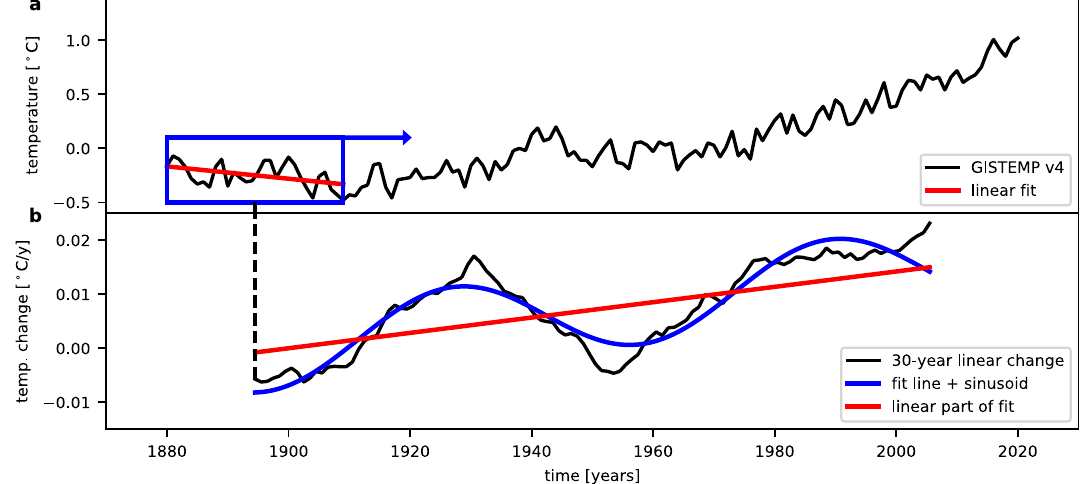
Figure 5. Long-term evolution of global annual mean surface temperatures. ( a ) The global annual mean surface temperature anomalies are shown as black curve. The blue box shows the first 30 year window used for the estimation of the linear temperature changes. Inside the box the result of the linear regression is displayed as red line. ( b ) The linear temperature changes (slopes of linear regression) in consecutive 30 year windows are shown as black curve at the mean times of the corresponding time window. The blue curve shows the result of a least squares fit of a line together with a sinusoid to the time series. The red line shows only the linear part of the same